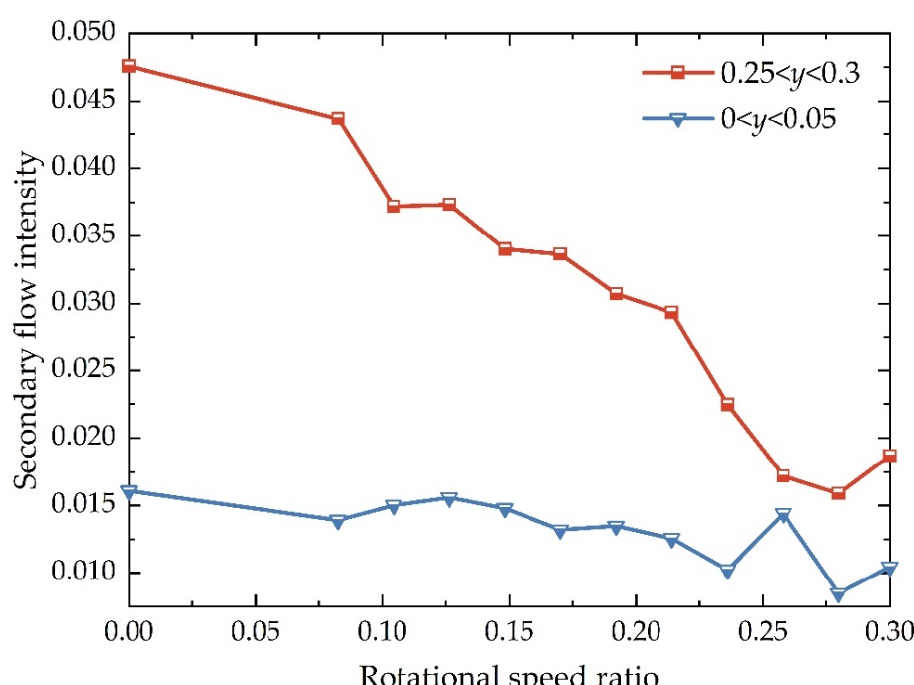
Figure 9. Secondary flow intensity at different speed ratios.